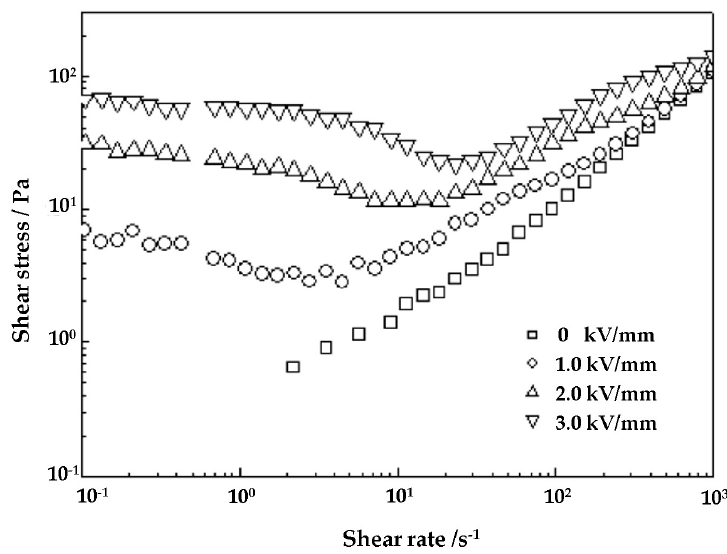
Figure 10. Shear stress versus the shear rate for the PMMA/PANI-based ER fluid (10 vol % in silicone oil) under various electric field strengths. (Lee et al. [121], Copyright Elsevier, 2005).